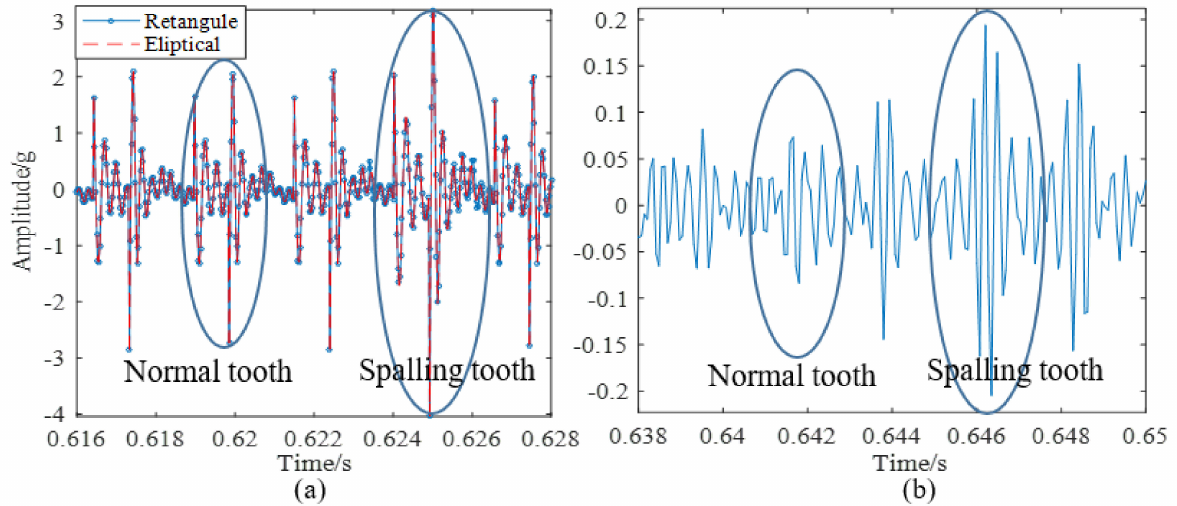
Figure 13. Local amplification of time domain signals: ( a ) Simulation signal, ( b ) Experimental signal, 4.2 dynamic simulation, and experimental verification of tooth spalling